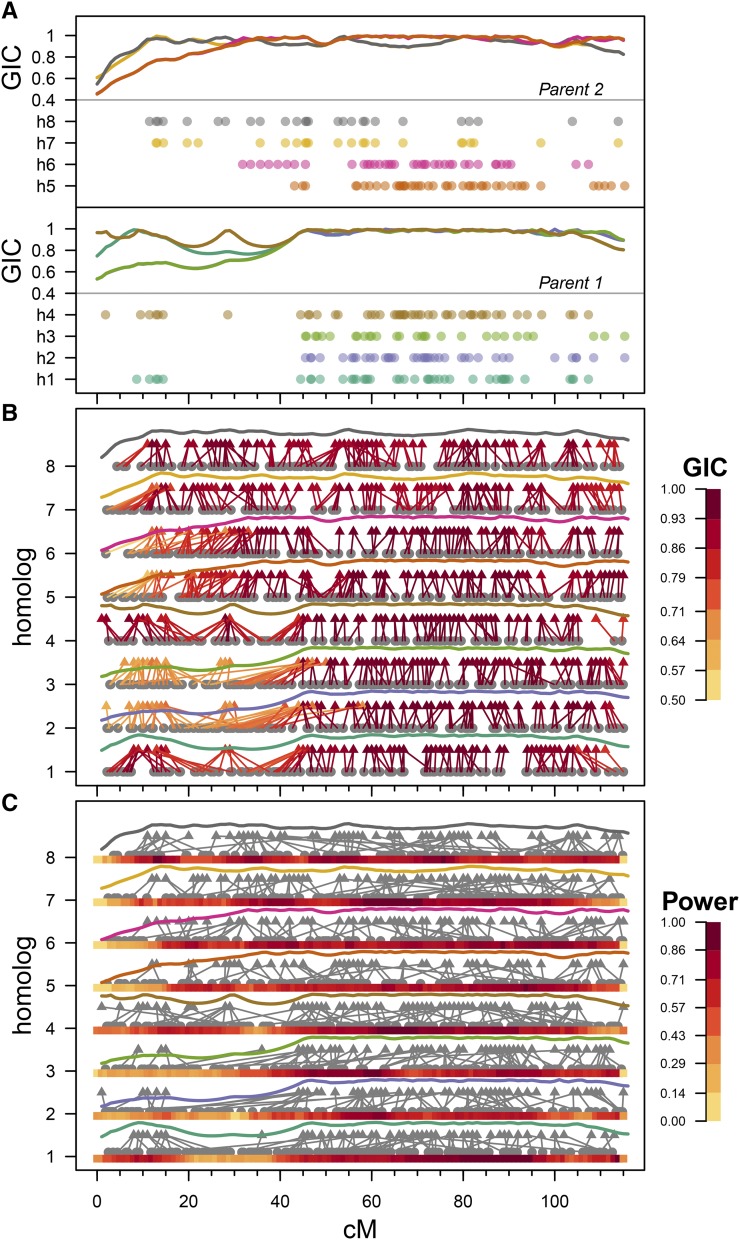
The effect of variable Genotypic Information Coefficient (GIC) explored. A. Influence of marker distribution on GIC values (calculated using noDR IBD probabilities) on potato chromosome 1 (Hackett et al. 2013), with parent 1 values in the lower panel and parent 2 values in the upper panel. Average GIC values over the 10 simulated populations are shown as lines above the marker distribution (and carry the same color). On the y-axis, h1 – h4 = parent 1 homologs 1 to 4, and h5 – h8 = parent 2 homologs 5 to 8. Occasionally GIC lines overlap, obscuring each other, although their profile logically follows the marker allele distribution shown. B. Effect of variable GIC on the precision of QTL detection. True QTL positions per homolog are represented by gray dots (each from a separate analysis – we did not simulate scenarios of more than one QTL per chromosome), with arrows indicating the position of the discovered QTL peak. Arrows are colored by the GIC content at the QTL position itself, with average GIC lines from Fig. 3.a shown above the arrows. The example shown corresponds to SxN additive QTL with a population size of 400, heritability of 0.2 and multivalent rate q = 0 analyzed using the noDR model. In this figure, all simulated QTL were detected (full power). C. Effect of variable GIC on the power of QTL detection, visualized on a per-homolog basis. Here, the power in a 10 cM sliding window is shown by a heat-map track below each homolog. QTL positions are shown as gray dots, with arrows indicating the position of the discovered QTL peaks. In contrast to (b), there was not full detection power (population size 200 and heritability = 0.1) – hence variation in QTL detection power along each homolog is apparent, and corresponds quite well with variations in the estimated GIC per homolog, shown above the arrows.